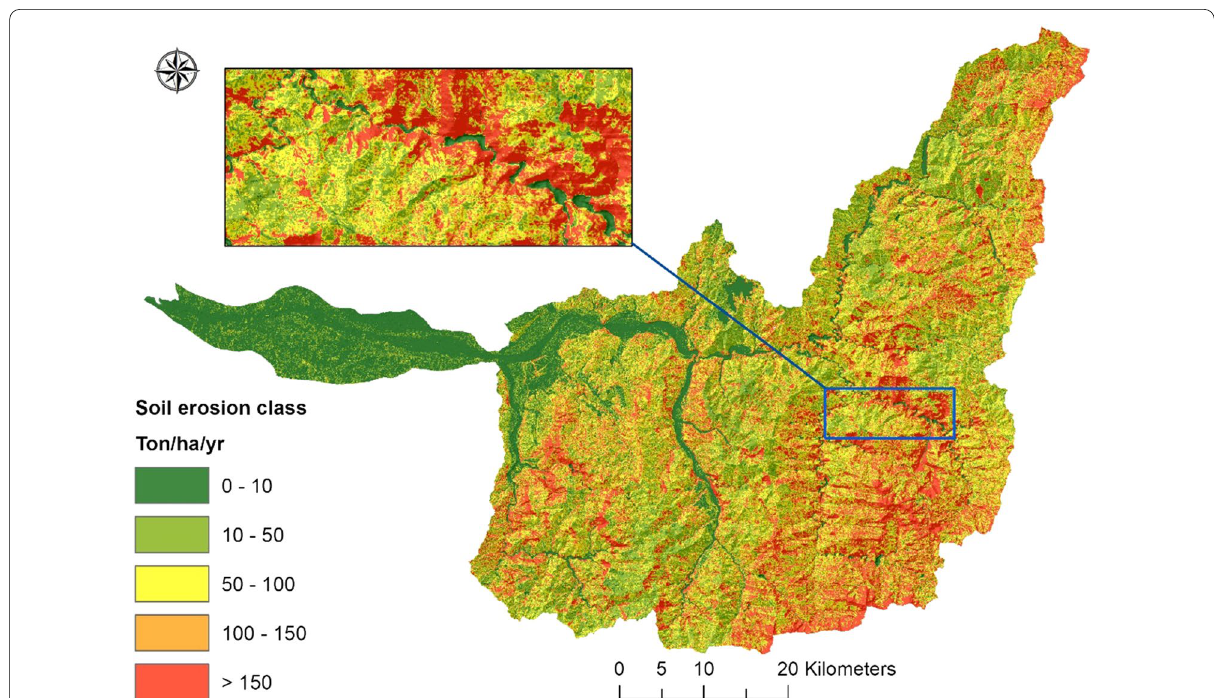
Fig. 6 Spatial distribution of soil erosion classes during 2005–2019; inserted image is zoomed‑in spatial pattern of soil erosion classes